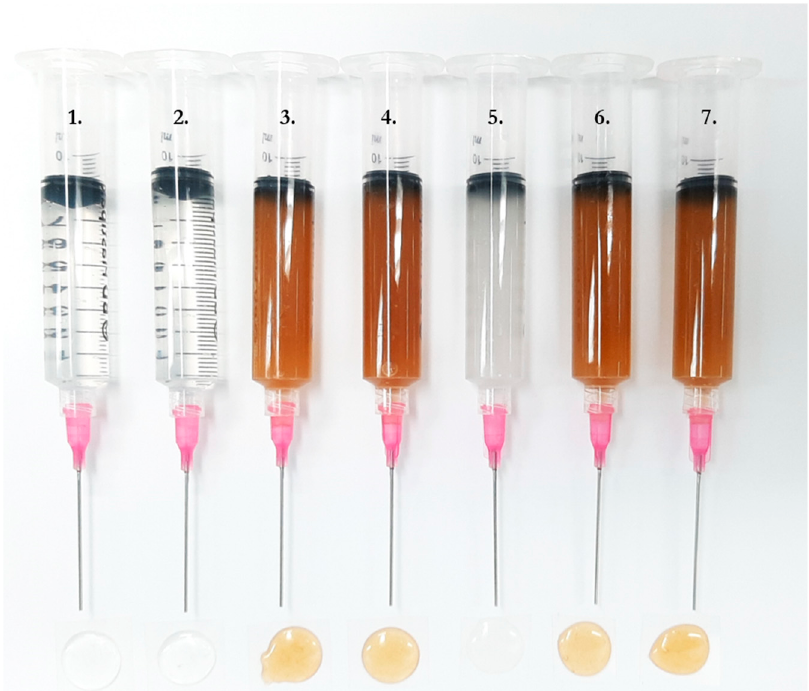
Figure 2. Solution-filled syringes attached with 1.5-inch 20 G precision dispensing tips and their extrudates. (1) Unloaded solution, (2) drug-loaded solution, (3) unloaded solution with liver powder, (4) drug-loaded solution with liver powder, (5) 2% drug-loaded solution, (6) nonprintable unloaded solution, and (7) nonprintable drug-loaded solution.